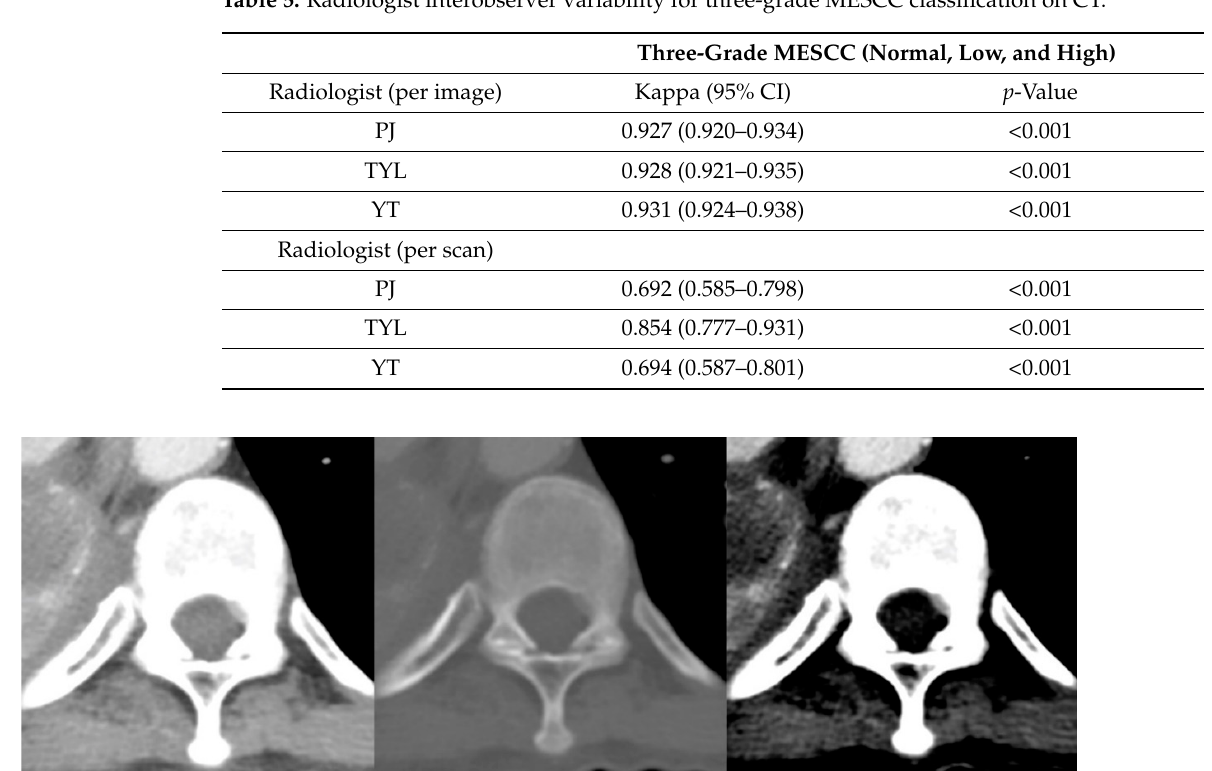
Table 5. Radiologist interobserver variability for three-grade MESCC classification on CT.